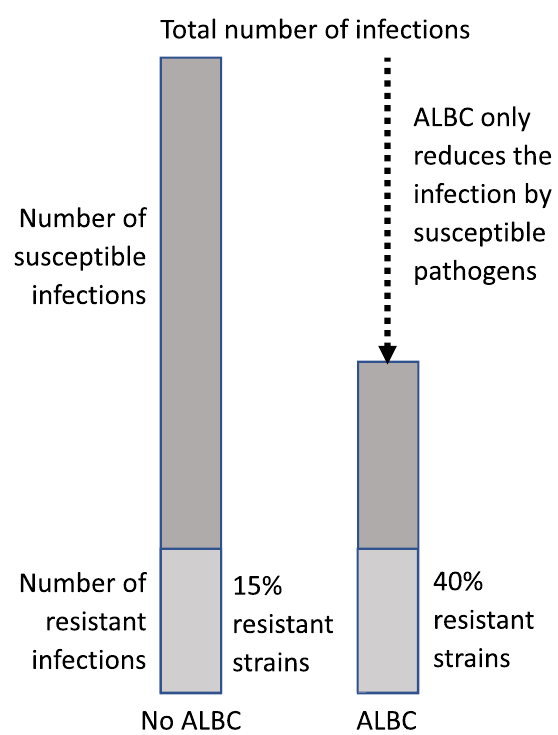
Fig. 3 Illustration of the impact of antibiotic‑loaded bone cement (ALBC) on the total number of infections and the consequent final percentages of susceptible and resistant pathogens (considering 100% prophylactic efficacy of local